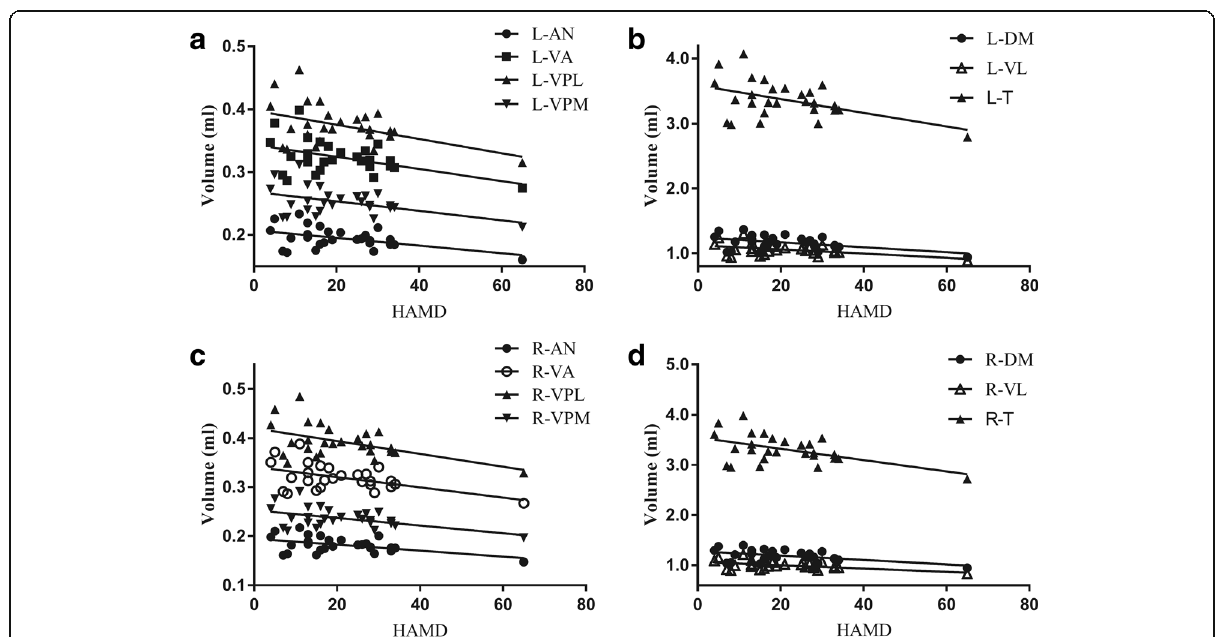
Fig. 4 The scatter plot between thalamic subnuclei volume and the HAMD score ( a and b , left thalamic subnuclei; c and d , right thalamic subnuclei). L, left; R, right; AN, anterior nucleus; DM, doromedial nucleus; VA, ventral anterior nucleus; VL, ventral lateral nucleus; VPL, ventral posterior lateral nucleus; VPM, ventral posterior medial nucleus; T, thalamus; HAMD, Hamilton Depression Scale